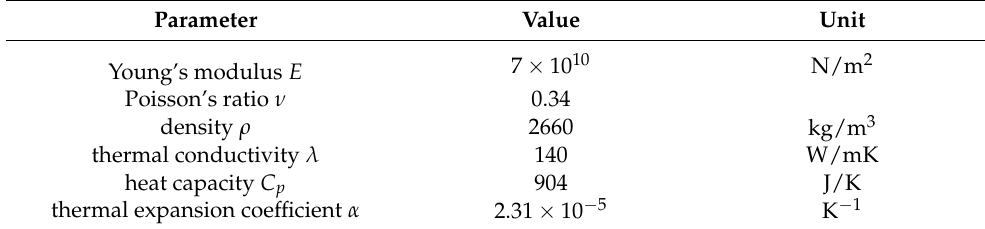
Table 1. Material parameters of the used aluminum